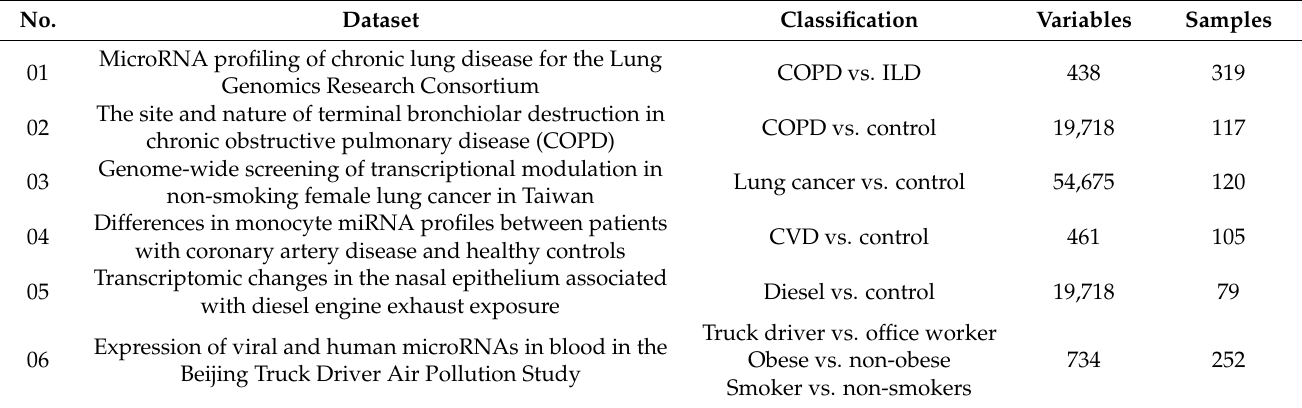
Table 1. Six datasets used in our